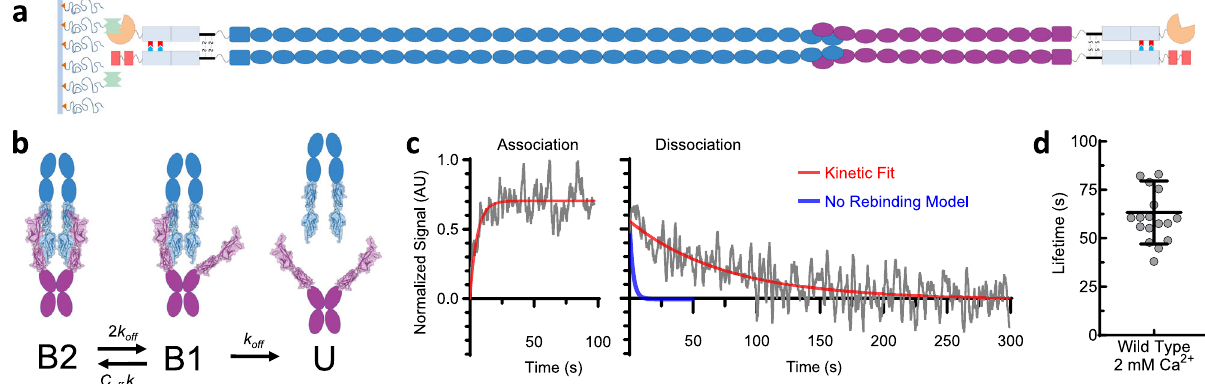
Fig. 2 The dynamics of the double-stranded tip-link connection. a Schematic of dimeric, full-ectodomain proteins, which were used for both biolayer interferometry and force-spectroscopy experiments, attached to the biolayer-interferometer sensor surface. Fc domains, SNAPtag, and tandem His6 tag as in Fig. 1b. b State diagram for tip-link avidity during dissociation. B2 is the doubly bound state, B1 the singly-bound, and U is unbound. k off is the single-bond off- rate. The rebinding rate B1 → B2 depends on the intrinsic on-rate k on and the effective concentration C eff , which is determined by the volume through which the unbound ends can move and remain in proximity. The N-terminal protein structure shown in the diagram is adapted from the Protein Data Bank (PDB) structure 4AXW. c Sample biolayer interferometry traces for dimeric full-ectodomain PCDH15 and CDH23 fusion proteins. An incident white light transmitted through the fi ber-optic sensor was differentially re fl ected from the glass sensor surface and from the bound protein layer (here CDH23); changes in the protein layer upon binding of a soluble protein (here PCDH15) produced the binding signal. (Left) Association timecourse enables calculation of C eff k on . (Right) The dissociation timecourse of the dimer ( fi t in red) indicates a long lifetime relative to the expected lifetime in the absence of rebinding (calculated in blue). Here, 320nM of both PCDH15 and EC1-2 truncated PCDH15 were used for the association phase (Supplementary Fig. 2c). d Scatter plot of tip-link connection lifetimes measured with biolayer interferometry at 2mM Ca 2 + (63±16s, mean ± SD, n = 18 independent